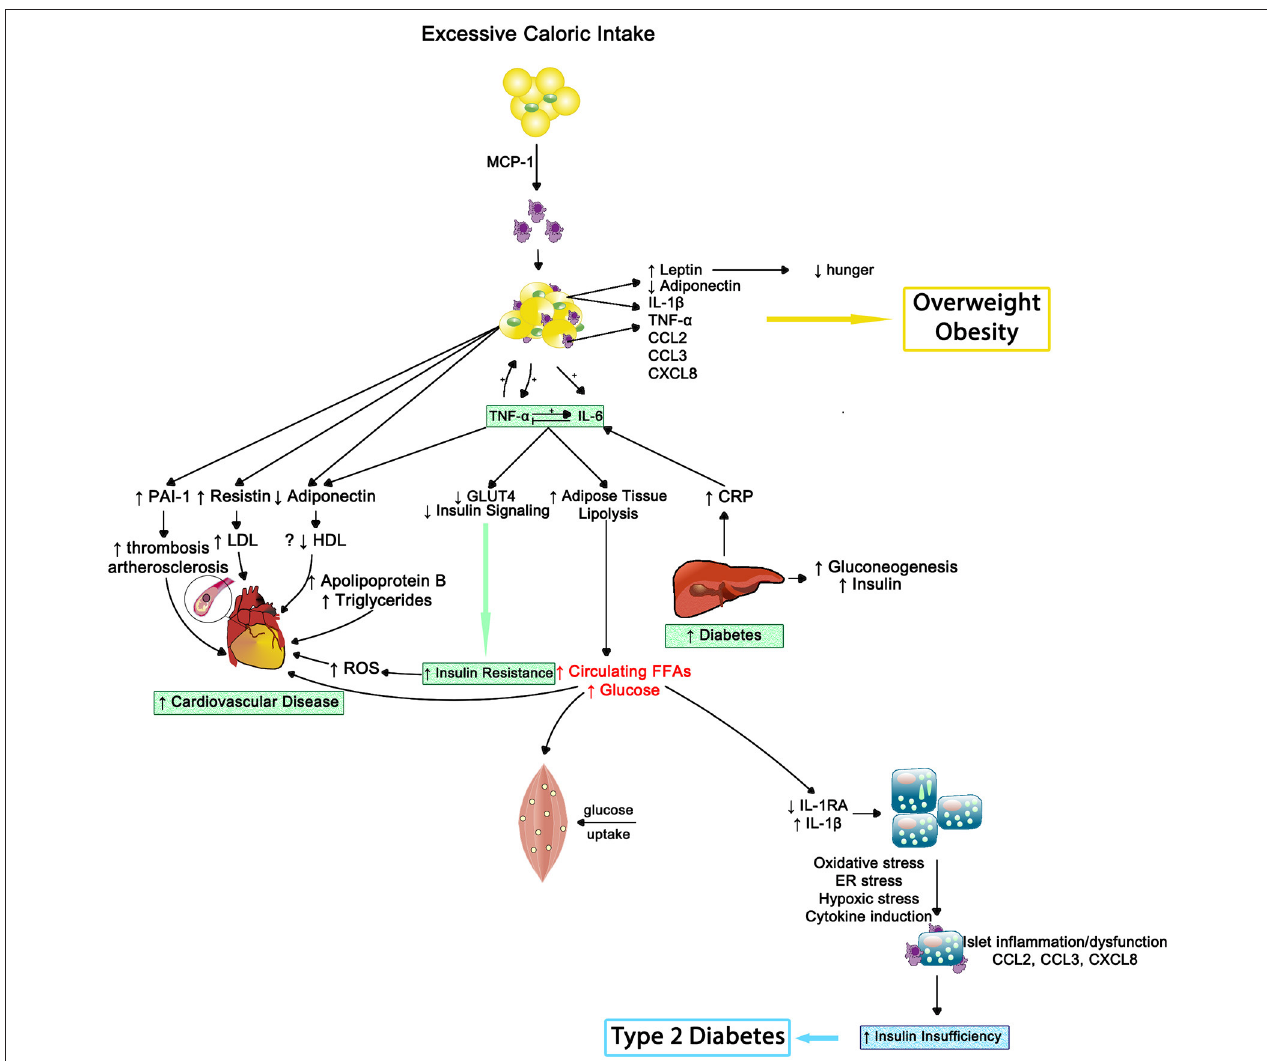
FIGURE 9 | The inflammatory effects of obesity on insulin resistance, cardiovascular disease and type 2 diabetes—Inflammation results in impaired muscle cell metabolism and insulin insufficiency. MCP-1, monocyte chemotactic protein 1; IL-1 β , interleukin-1beta; TNF- α , tumor necrosis factor alpha; IL-6, interleukin-6; CCL2, CC chemokine ligand 2; CCL3, CC chemokine ligand 3; CXCL8, CXC chemokine ligand 8; PAI1, plasminogen activator inhibitor type 1; LDL, low density lipoprotein; HDL, high density lipoprotein; ROS, reactive oxygen species; GLUT4, insulin-regulated glucose transporter type 4; CRP, C-reactive protein; FFAs, free fatty acids; IL-1RA, interleukin-1 receptor antagonist; ER, endoplasmic